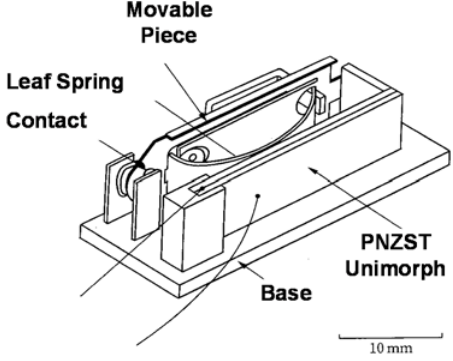
Figure 19. Structure of the latching relay using shape memory ceramic.